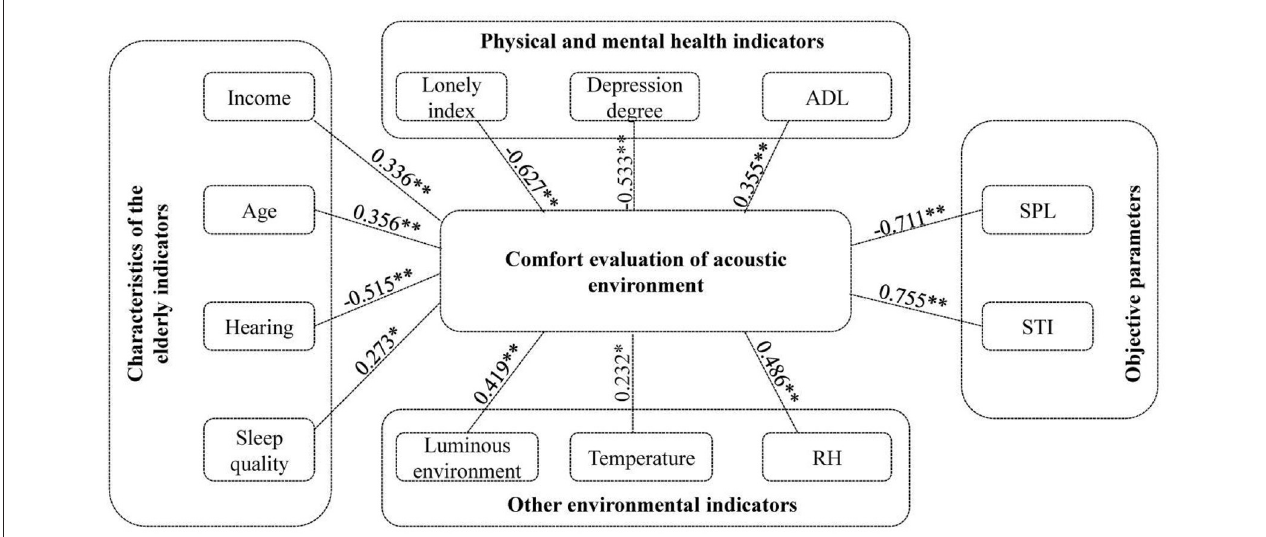
FIGURE 5 | The relationship between different variables and comfort evaluation of acoustic environment. **indicates that the two-tailed test is significant at the level of 0.01, and *indicates that it is significant at the level of